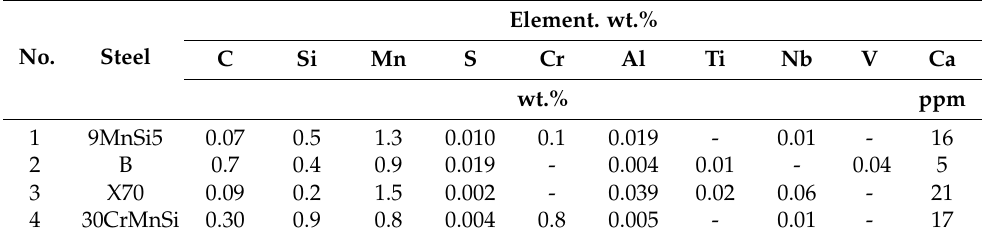
Table 1. Chemical composition of the studied